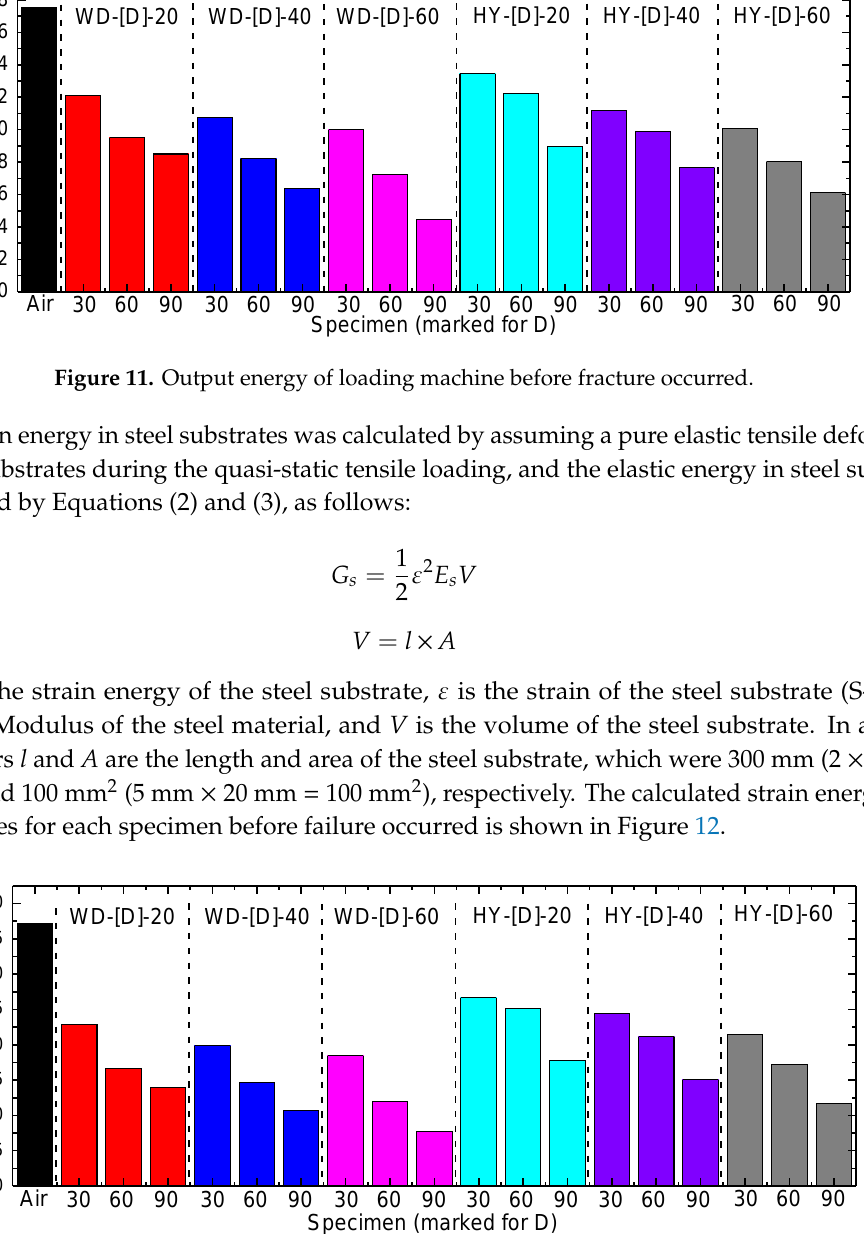
Figure 12. Strain energy of steel substrates before fracture occurred.